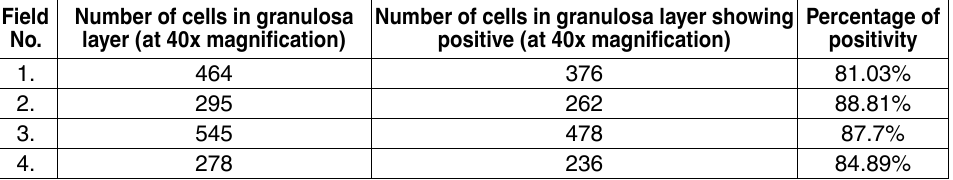
table 3. Percentage of positivity of Ang-2 expression in theca interna cells of antral follicle Field Number of cells in thecal layer No. (at 40x magnification)